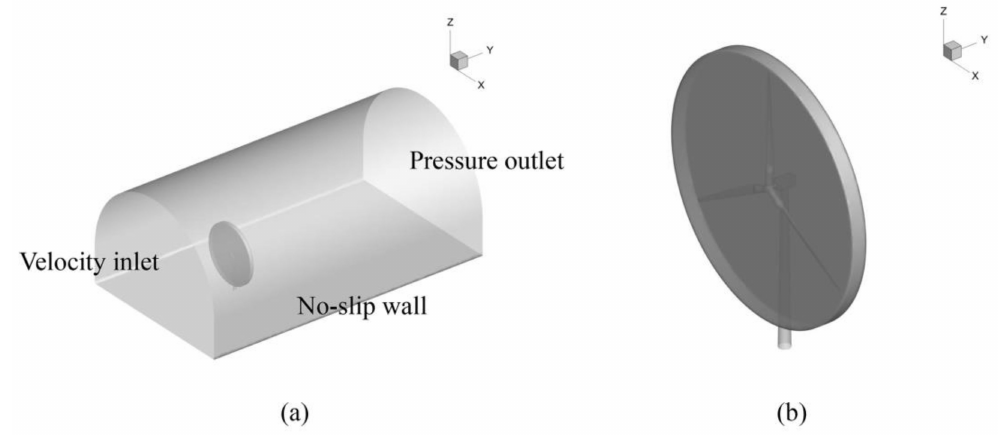
Figure 2. Computational domain of wind turbine flow field: ( a ) external domain; ( b ) rotational